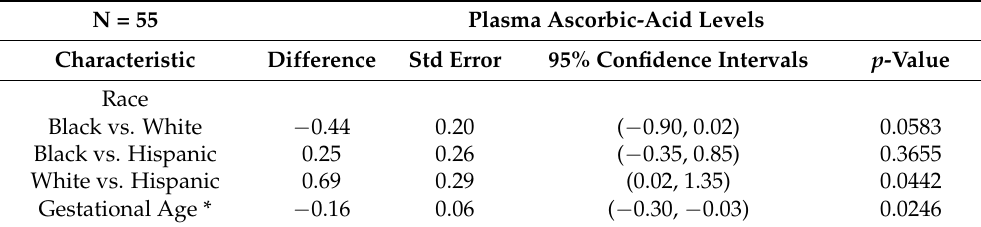
Table 4. Early plasma ascorbic-acid levels and infant